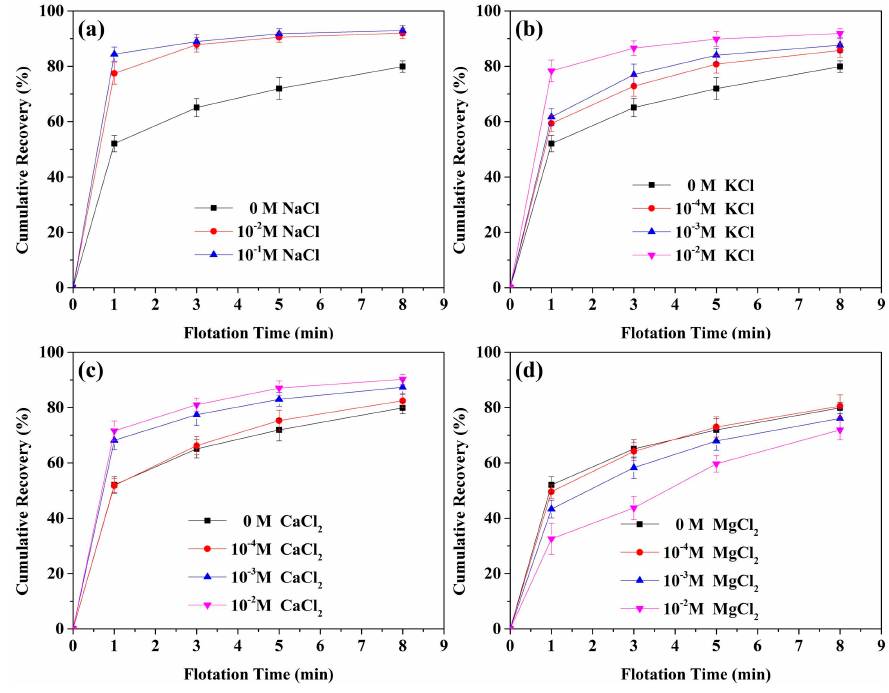
Figure 2. The effects of salts on chalcopyrite recovery: ( a ) NaCl; ( b ) KCl; ( c ) CaCl 2 ; and ( d ) MgCl 2 .